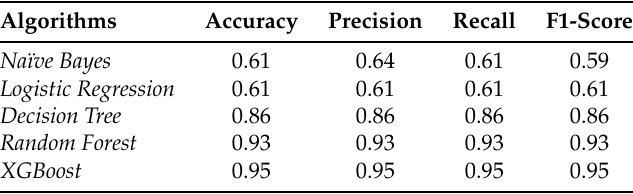
Table 1. Performance evaluation.